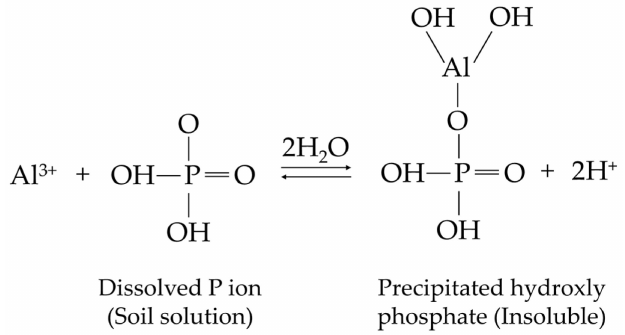
Figure 2. Precipitation reaction in the phosphorus fixation process [47].